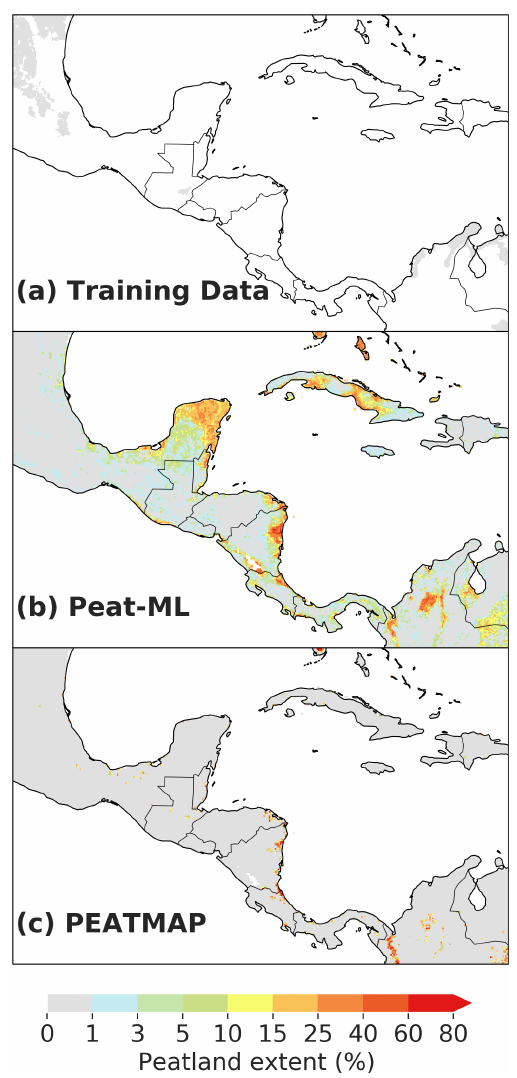
Figure A6. Peatland extent over Central America. Panel (a) shows the ML training data, panel (b) shows the Peat-ML-predicted peatland extent, and panel (c) shows the PEATMAP extent from Xu et al.